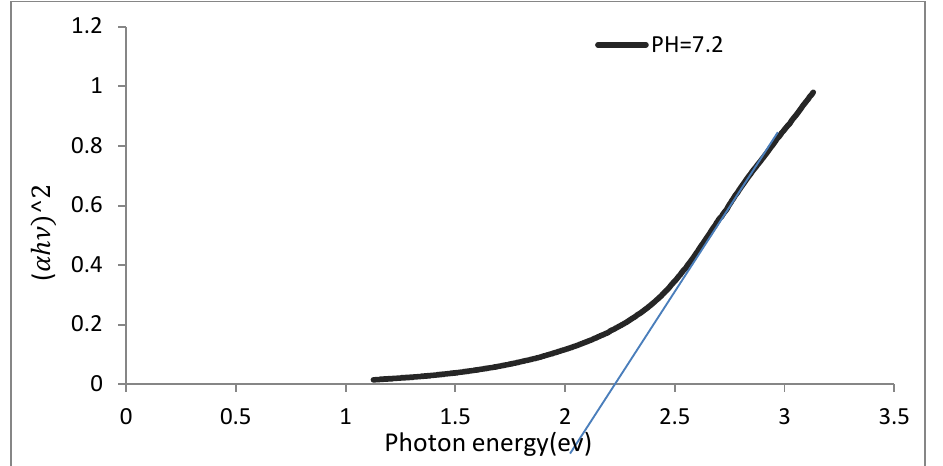
Figure 5: The optical energy gap CdO thin film at